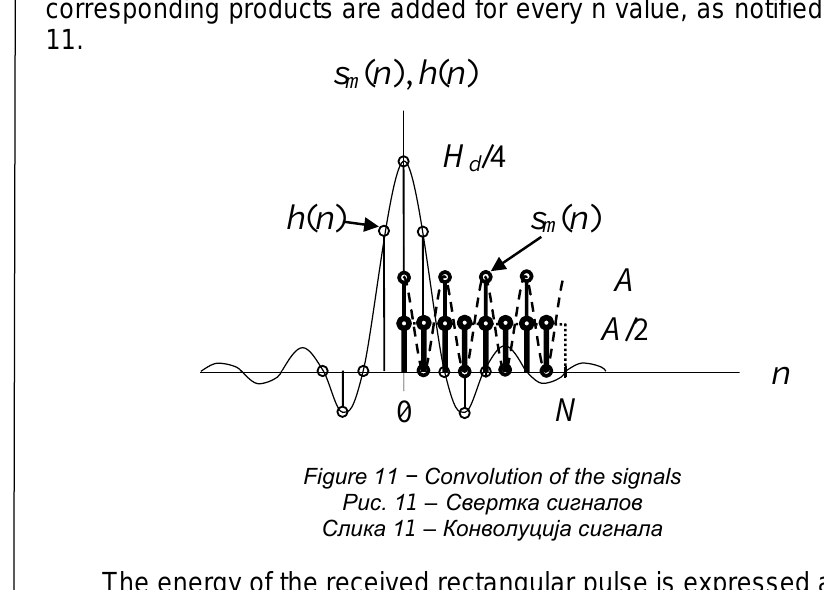
Figure 11 − Convolution of the signals Рис. 11 – Свертка сигналов Слика 11 – Конволуција